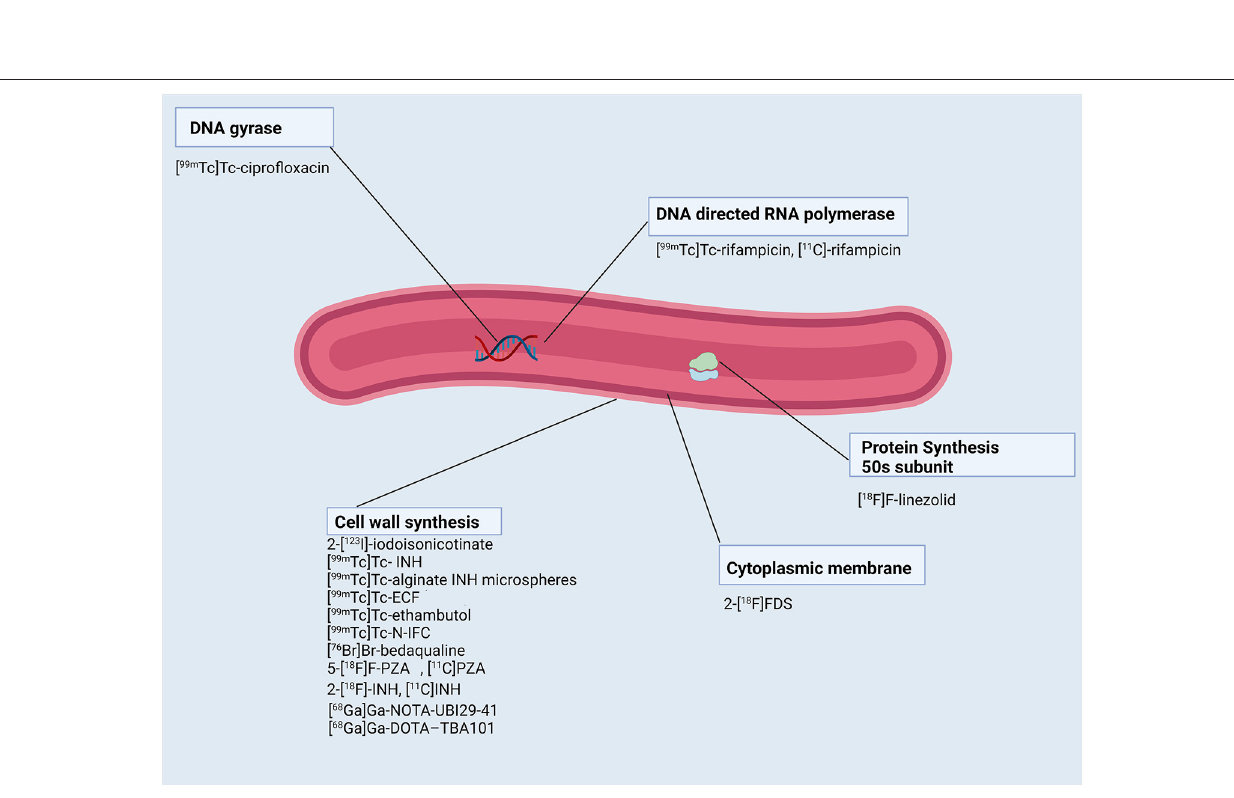
Frontiers in Medicine |